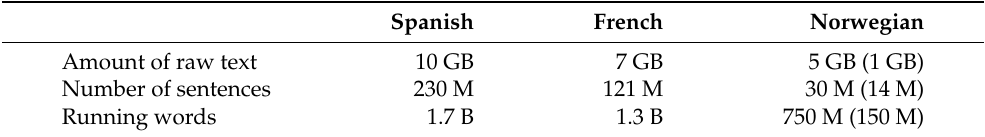
Table 5. Statistics of the corpora used to pretrain the GPT-2 model in Spanish, French and Norwegian. In Norwegian, values in brackets refer to the data prior to the addition of the OSCAR corpus.